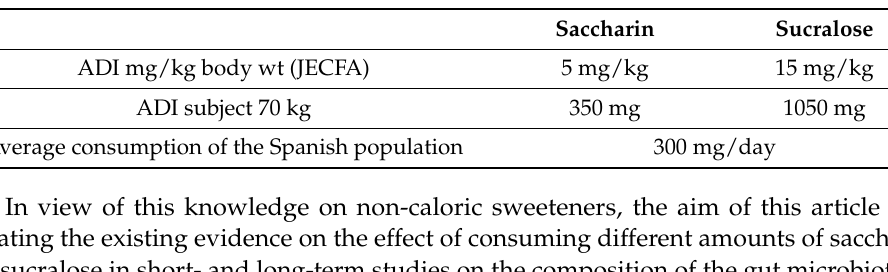
Table 2. ADI. Mean consumption of sweeteners in the Spanish